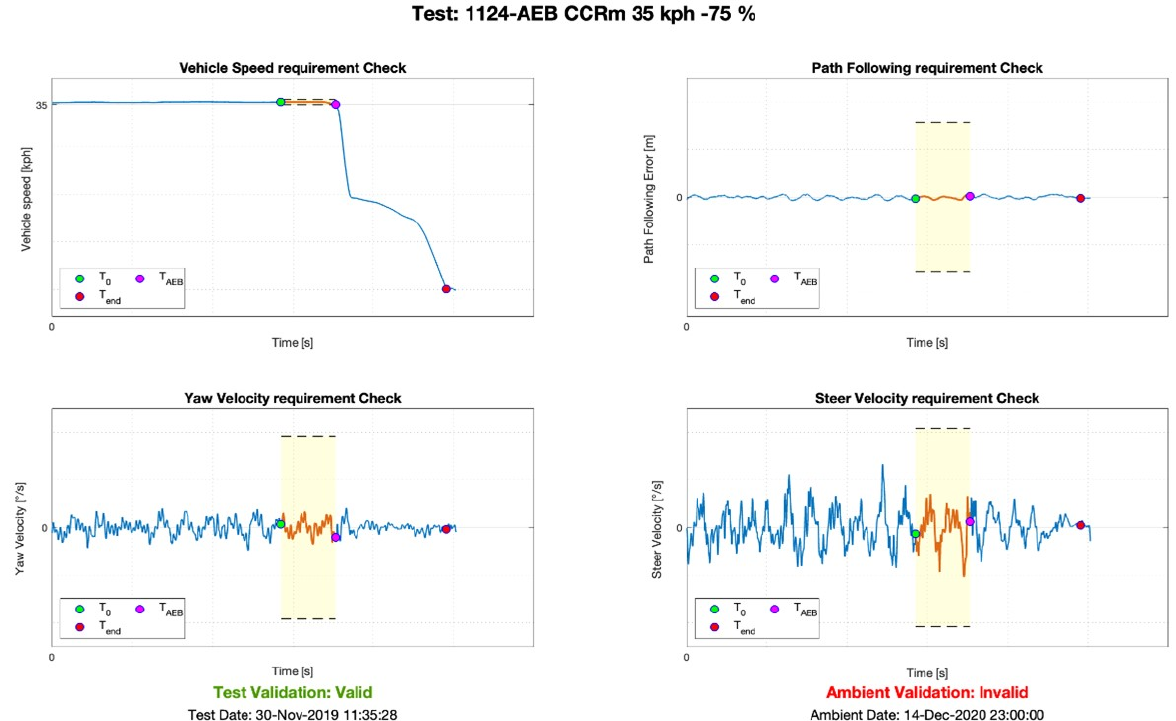
Figure 20. Post-processing results for a valid test CCRm.